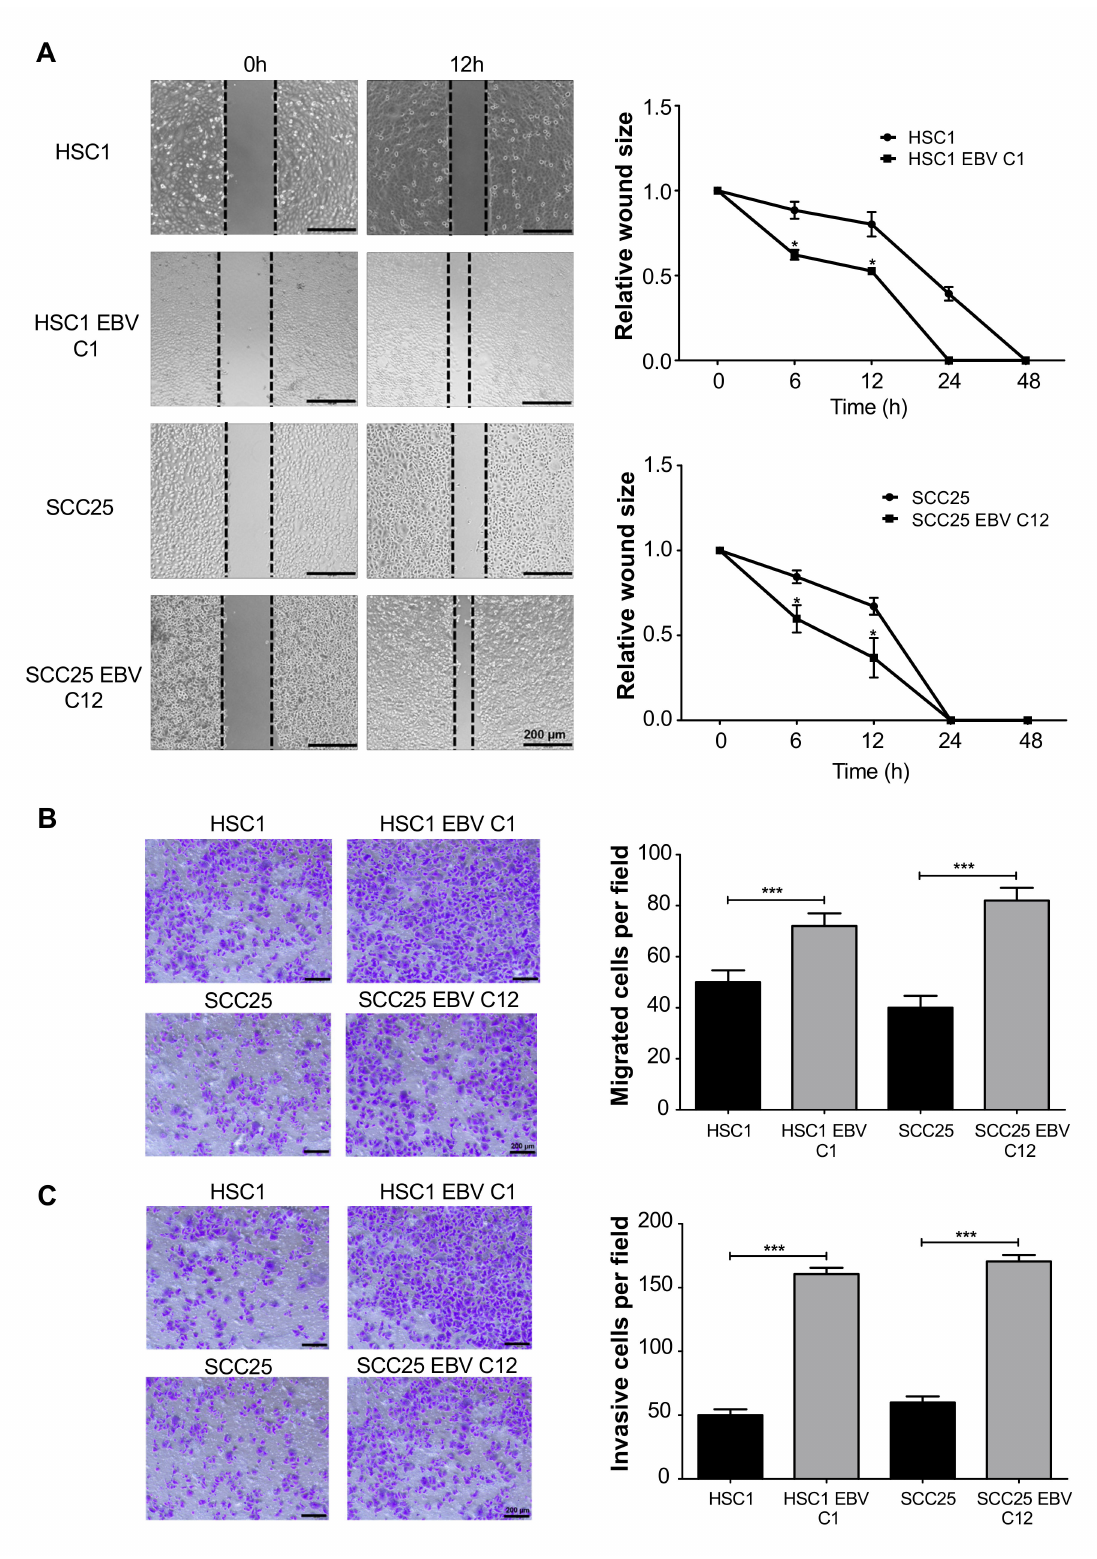
Figure 7. EBV infection induces cell migration and invasion. The e ff ect of EBV infection on cell migration in EBV-infected HSC1 cells and SCC25 cells was examined by wound healing assay ( A ) and transwell assay ( B ). Invasion of EBV-infected HSC1 cells and SCC25 cells was analyzed by transwell assay ( C ). *: p < 0.05; **: p < 0.01; ***: p < 0.001. Scale bar: 200 µ